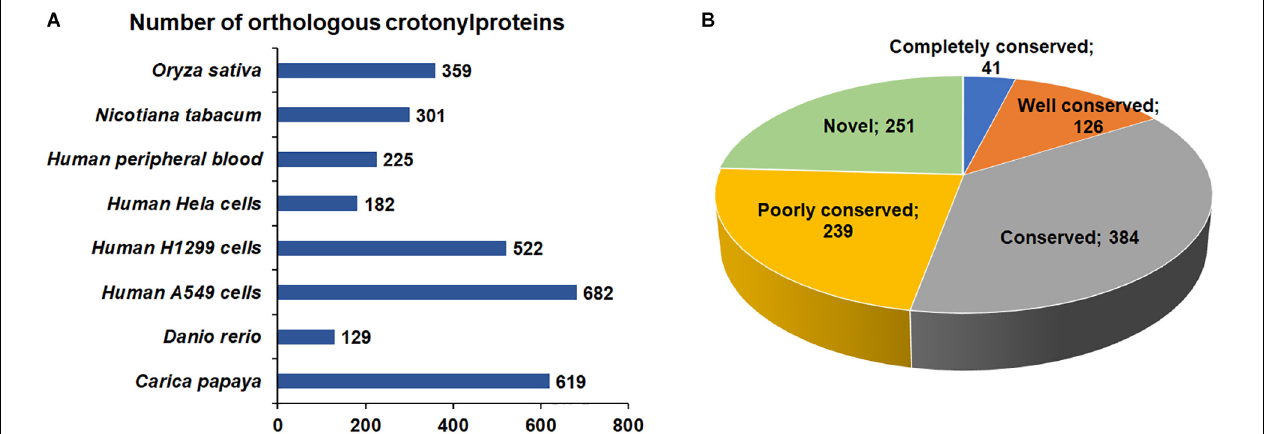
FIGURE 2 | Conservation analysis of lysine crotonylated proteins. (A) Number of orthologous crotonylproteins in eight organisms or cell lines with reported crotonylomes. (B) A pie chart of conservation of crotonylproteins in Oryza sativa , Nicotiana tabacum , Human peripheral blood , Human Hela cells , Human H1299 cells , Human A549 cells , Danio rerio , and Carica papaya . Classification was performed as follows: Completely conserved group, 8 orthologs; Well conserved group, 6 to 7 orthologs; Conserved group, 3 to 5 orthologs; Poorly conserved group, 1 to 2 orthologs; Novel group, 0